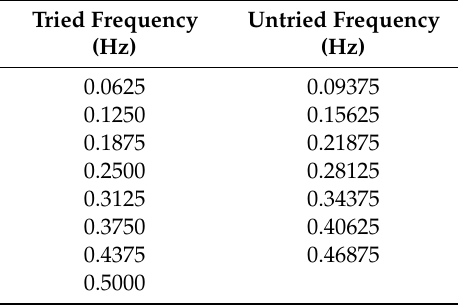
Table 2. Tried and untried frequencies (0.0625–0.5 Hz) for the target models with all hydrocarbon depths. There were 15 datasets of EM response for each depth, hence the total number of datasets were 45. All frequencies employed in this research work were set to have a gap of